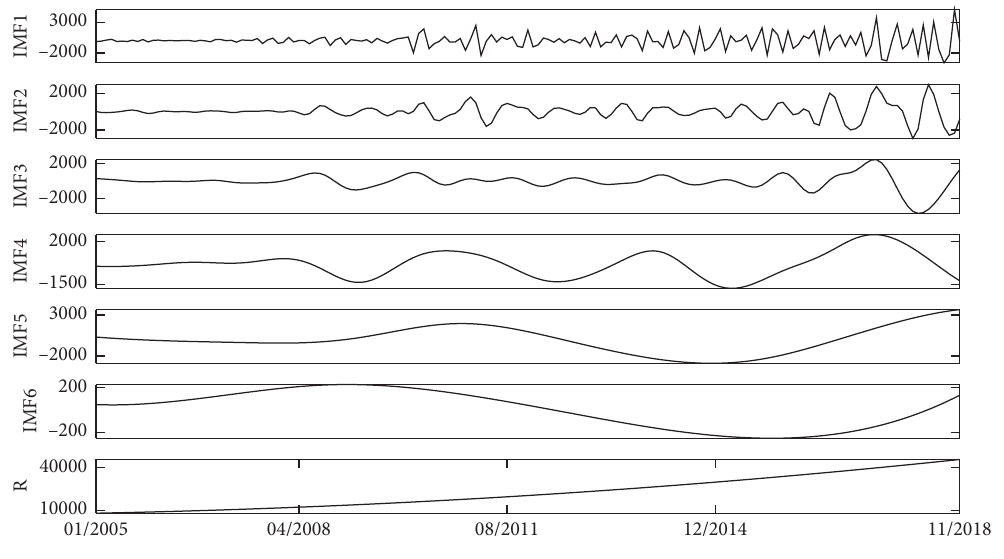
Figure 3: The IMFs and a residual of house prices via Table 3: Measures of IMFs and residual in the house price series.